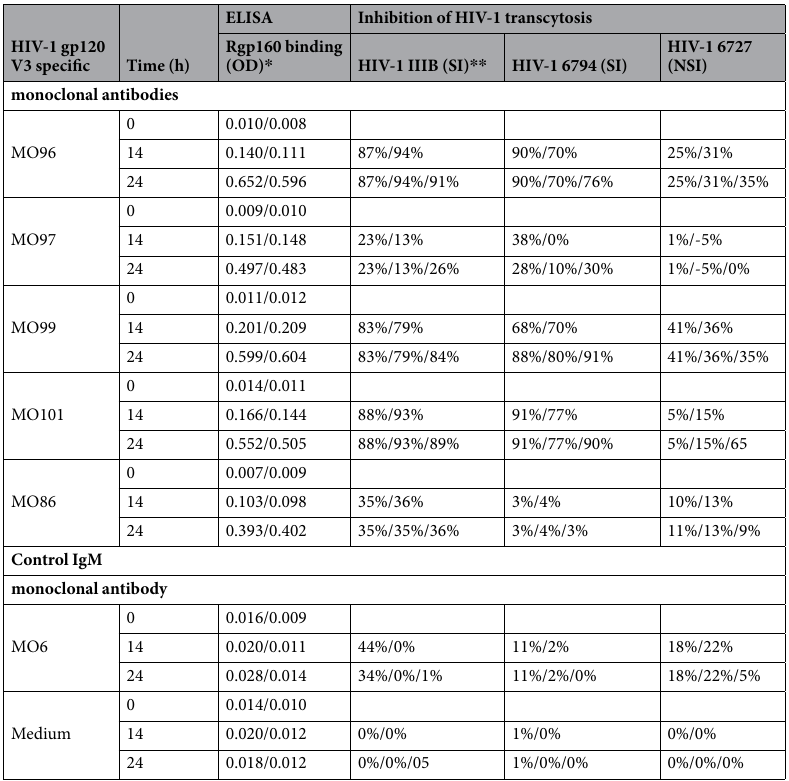
Secretory IgA and IgM antibodies can be efficiently transcytosed and may function as the first specific bar- rier against infection 19,27,44 . However, polymeric IgA is more efficiently transcytosed than polymeric IgM 44,45 . Virus-neutralizing antibodies in mucosal surfaces, such as interactions between IgA and influenza or Sendai viral